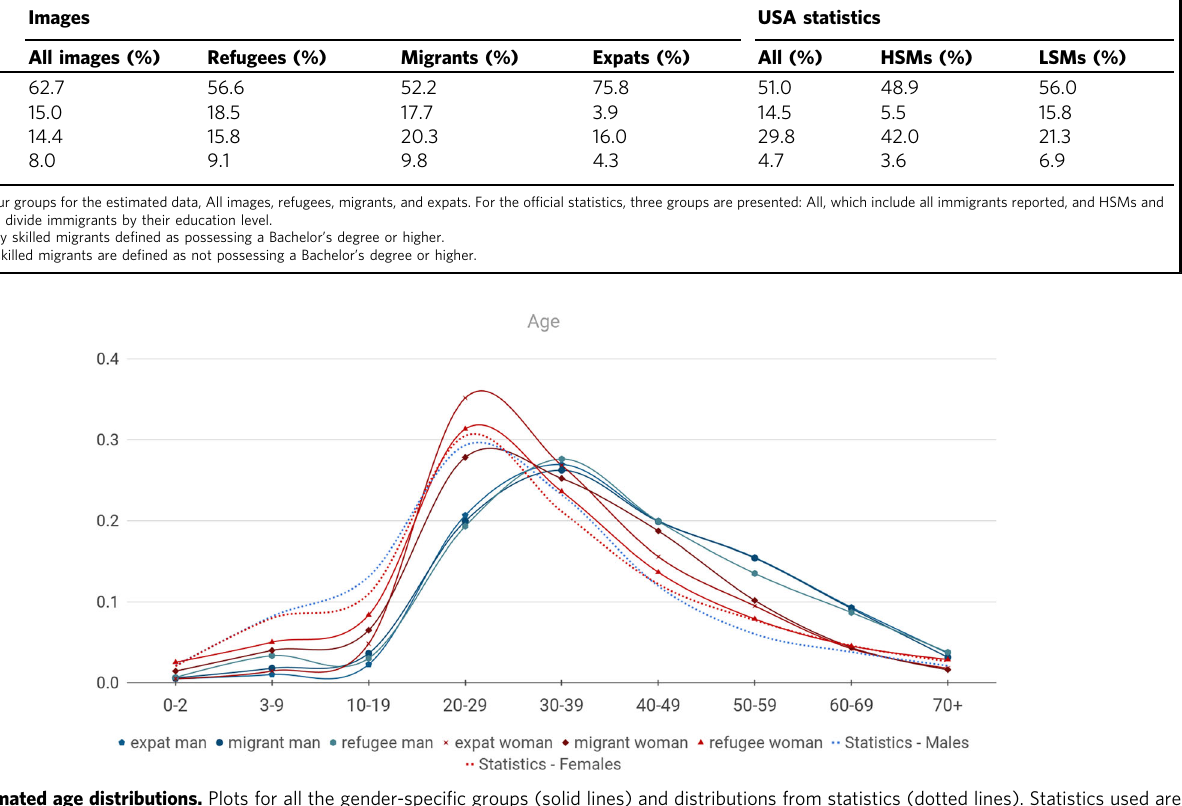
Table 4 Comparison of proportions for facial features estimated from images and statistics from the USA. Group Images